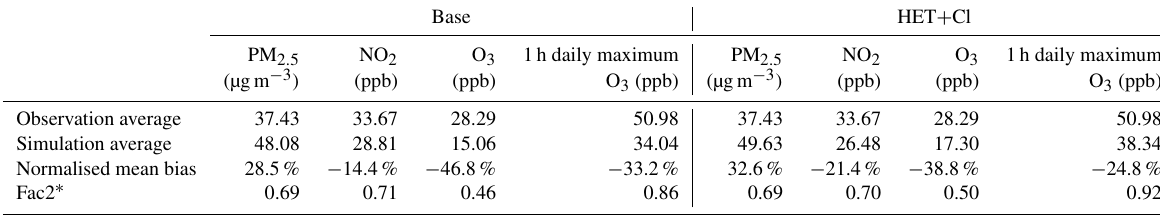
Figure 1. (a) Domain settings of WRF-Chem simulations and (b) the terrain in domain 2 (southern China). The red dotted line represents the vertical domain that intercepts the most polluted PRD region along the prevailing wind direction (north-east). TMS is the location of the site where N 2 O 5 and ClNO 2 were measured. HK and PRD are the general locations of Hong Kong and the Pearl River Delta region. Table 3. Comparison of chemical simulation with observation for the base case and the HET + Cl